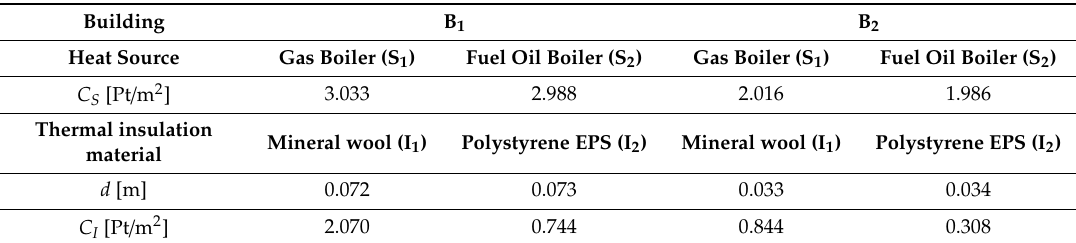
Table 5. Ecological costs of replacing the C S boiler and ecological costs associated with the production of C I thermal insulation materials.